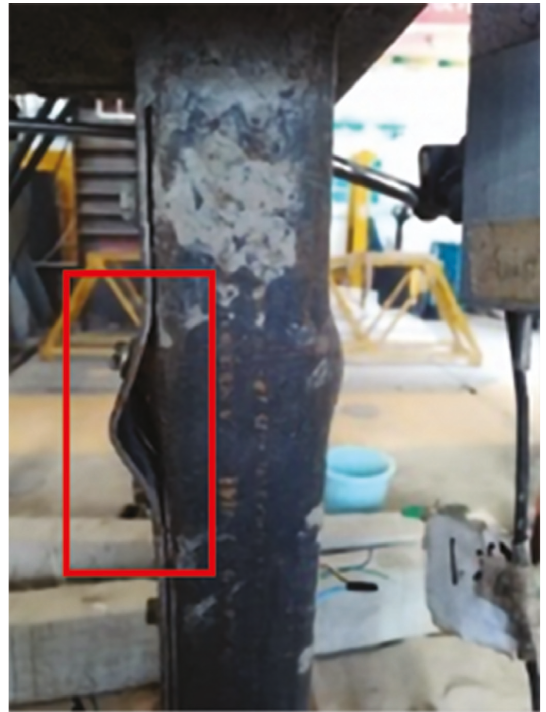
Figure 7: Local buckling